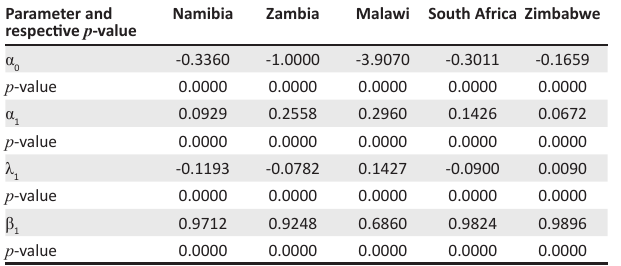
TABLE 6: Exponential generalised autoregressive conditional heteroscedasticity results assuming Student’s t -distribution. Parameter and respective p -value